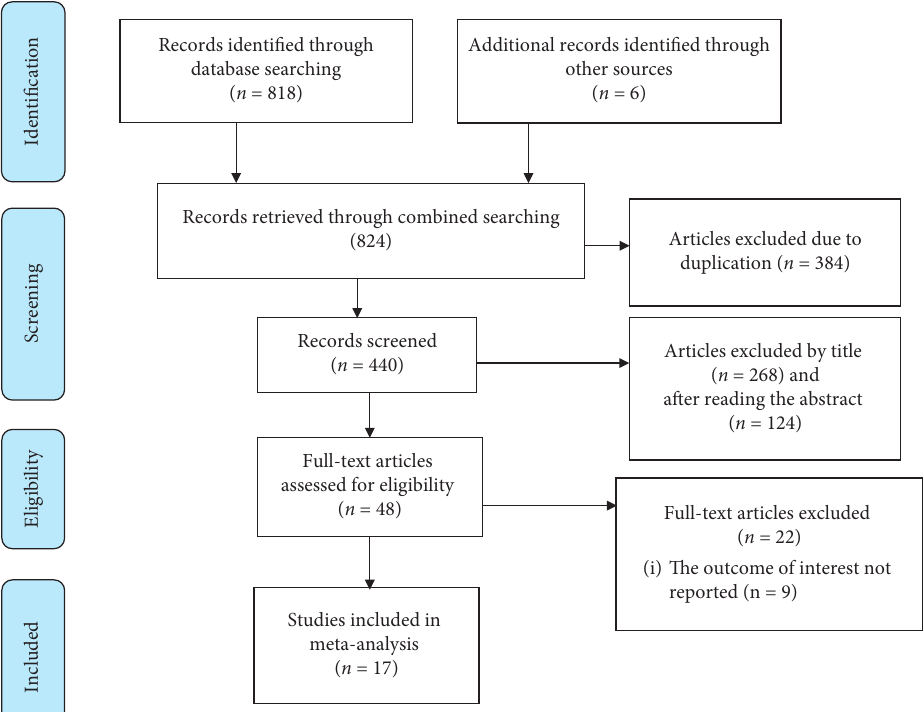
Figure 1: Flow chart of study selection for systematic review and meta-analysis to estimate the level of self-care practice among hypertensive patients in